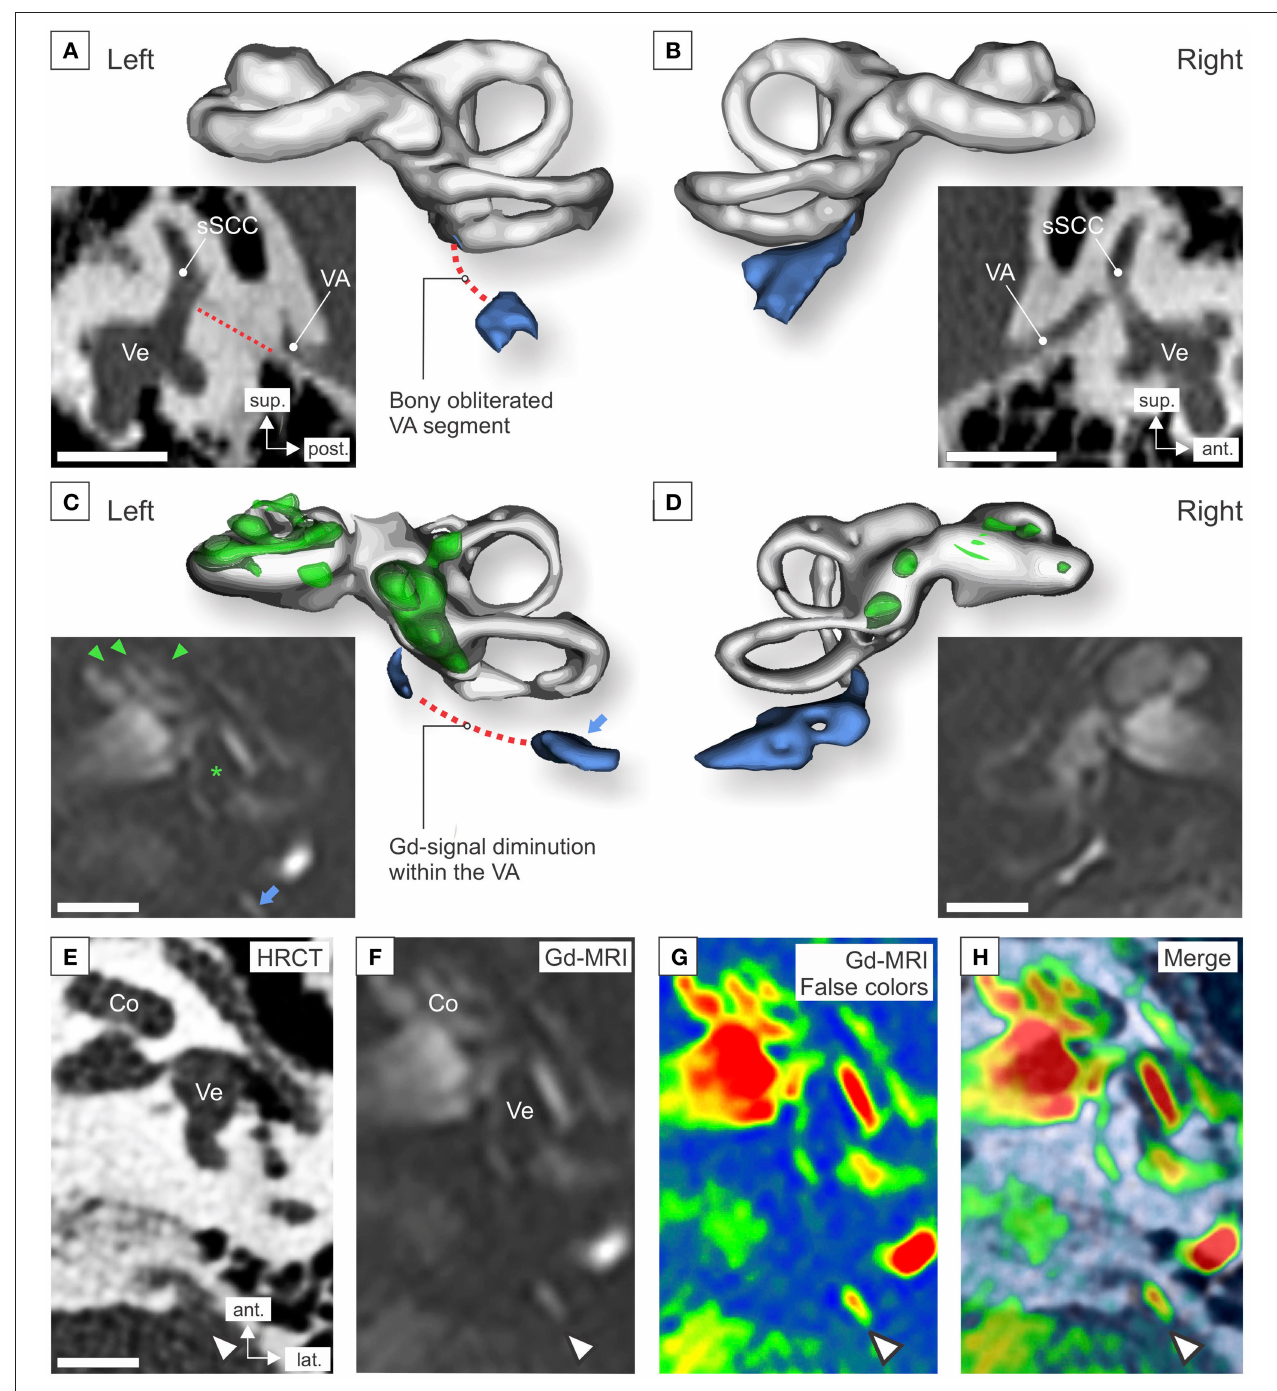
FIGURE 2 | High-resolution CT (HRCT) imaging and gadolinium-enhanced MRI (Gd-MRI) of the inner ears was performed after the onset of Meniere’s symptoms (HRCT, at age 44; Gd-MRI, at age 48). (A,B) Sagittal HRCT projections and 3D segmentations of the left (A) and right (B) labyrinth. (VA, vestibular aqueduct (blue in 3D segmentation); sSCC, superior semicircular canal; Ve, vestibule; red dotted line in (A) , bony obliterated VA. (C,D) Axial Gd-MRI (3D inversion recovery sequence) and 3D segmentations of the left (C) and right (D) labyrinth. Signal voids in the cochlear turns (green arrowheads) and the saccule (green asterisk) indicate endolymphatic hydrops; blue arrow, signal originating from the extraosseous endolymphatic sac. 3D segmentations were performed using the 3D Slicer software [version 4.6.2, (12)]. (E–H) Fusion of axial HRCT (E) and Gd-MRI [ F ; false color-coded image in (G) ] images of the left temporal bone in the corresponding axial plane (H) . Arrowheads (E–H) : T2 signal localized posterior to the operculum, corresponding to the localization of the distal (extraosseous) endolymphatic sac (D) . (Co, cochlea; PSCC, posterior semicircular canal; VA, vestibular aqueduct; Ve, vestibule). Scale bars: 5mm. The false color-coding image overlay was generated using Adobe Photoshop CC2017 (version 18.1.0, San Jose, CA, USA).